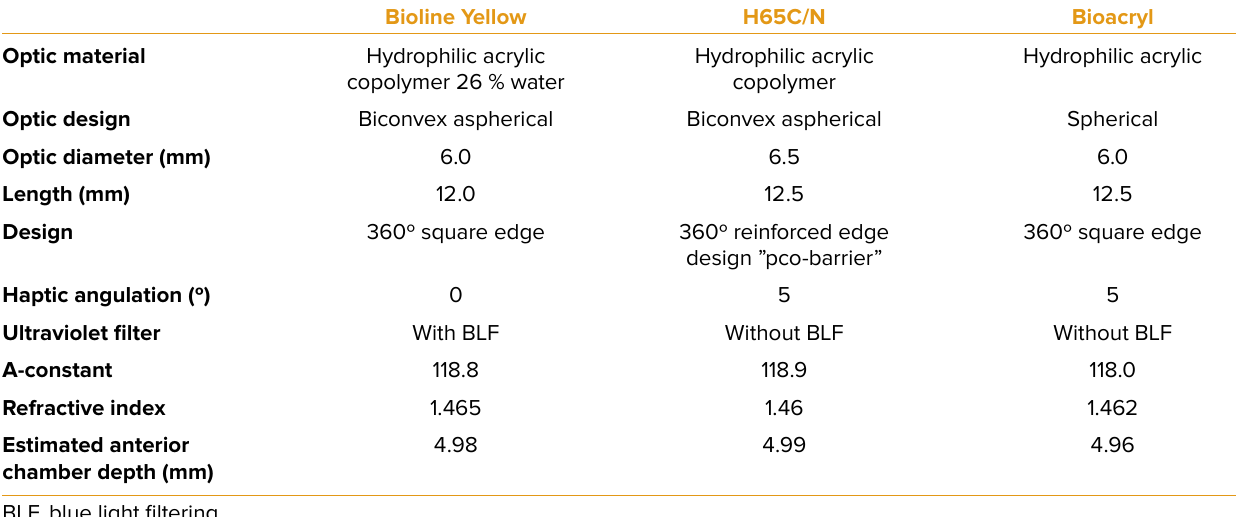
Table 1. Main characteristics and special features of the intraocular lenses used in the study